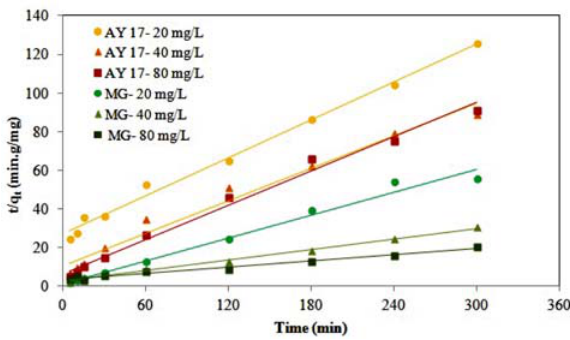
Figure 9. Pseudo second-order kinetics of MG and AY